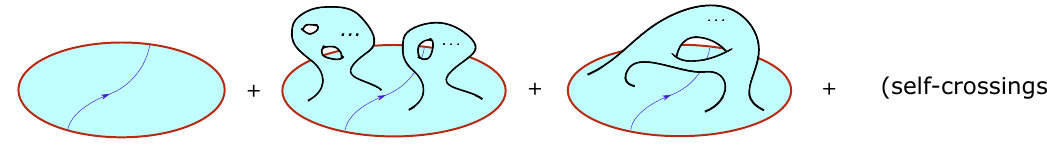
Figure 17 . Topological corrections to the boundary two-point function. We sum over topological excursions on both sides of the Wilson line, with both connected and disconnected contributions. Also corrections with Wilson lines with self-crossings have to be considered.